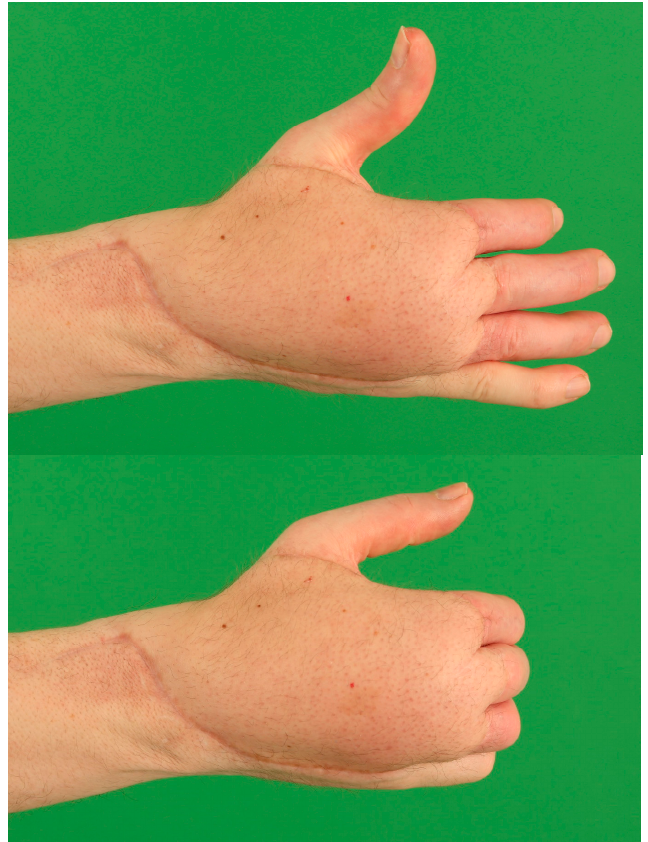
Figure 9. Result six months after free flap procedure. Wound healing is completed and the free flap shows a thin contour facilitating movement of the remaining finger joints. Reconstructive failure due to flap loss was observed in one case (7%), where second- ary defect closure using a pedicled groin flap was necessary. In addition, five microsurgi- cal revisions were required because of arterial thrombosis (7%), venous insufficiency (14%), or hematoma (14%). Routine rotational thromboelastometry (ROTEM) during pre- operative evaluation showed hypercoagulopathy in ten patients (71%) consistent with a hypercoagulative state that is described as beginning 48 h after trauma [20,35,36]. All doc- umented operative revisions and flap loss occurred in patients with altered coagulation and nearly all complications occurred in patients with a delay of 19 to 30 days between burn trauma and defect reconstruction. Cho et al. presented a series of 518 free flaps for lower limb reconstruction at the Duke University and the University of Pennsylvania, and showed an overall rate of flap loss of 8.3% [37]. Zhang et al. found a total flap loss rate of 6.0% in a pooled collective of upper limb reconstructions in a recent meta-analysis [38]. Hence, the observed rate of flap failure in our burn cohort is in line with cohorts of other traumatic limb defects undergo- ing microvascular reconstruction. It shows that free flaps are a reliable tool in defect re- construction in burned patients when the measures described above were considered. Al- teration in coagulation and timing of the free flap procedure seem to be of special rele- vance in this group of patients. In secondary scar reconstruction, where the recipient sites are usually closed, non- infected, and hemodynamic and rheological alterations have been compensated, most of